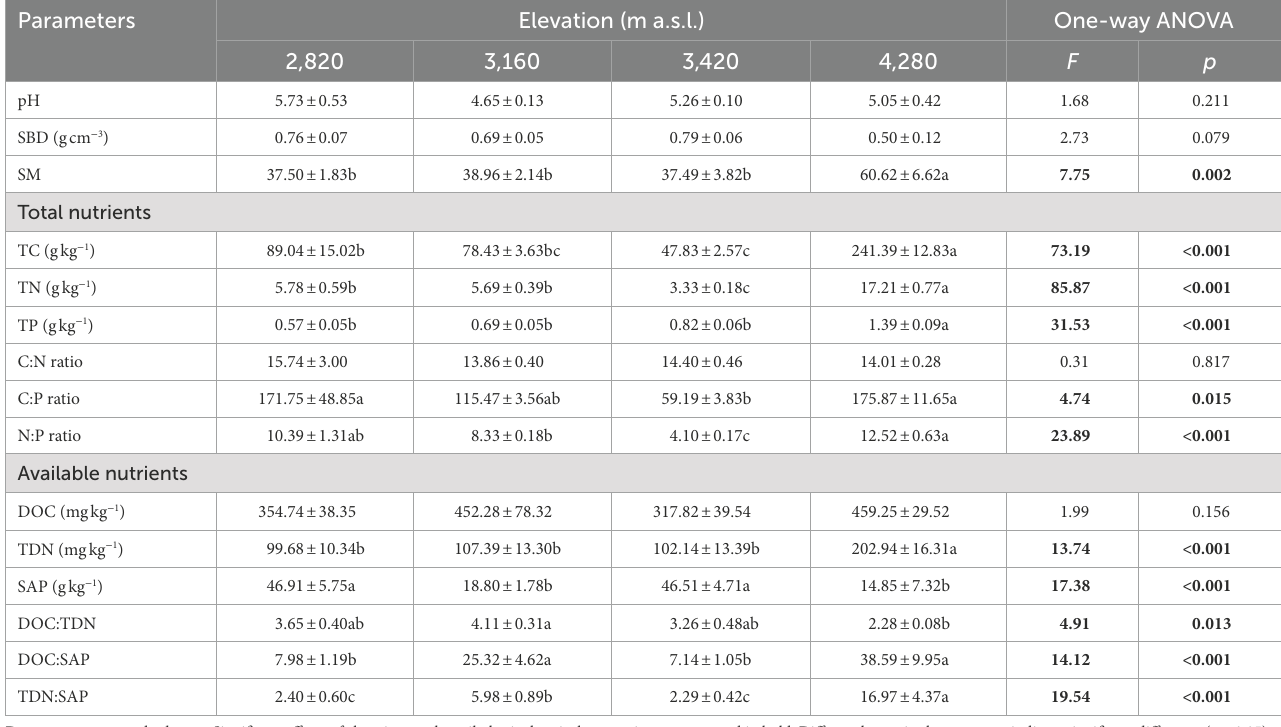
TABLE 2 Soil physiochemical properties along the elevational gradient.